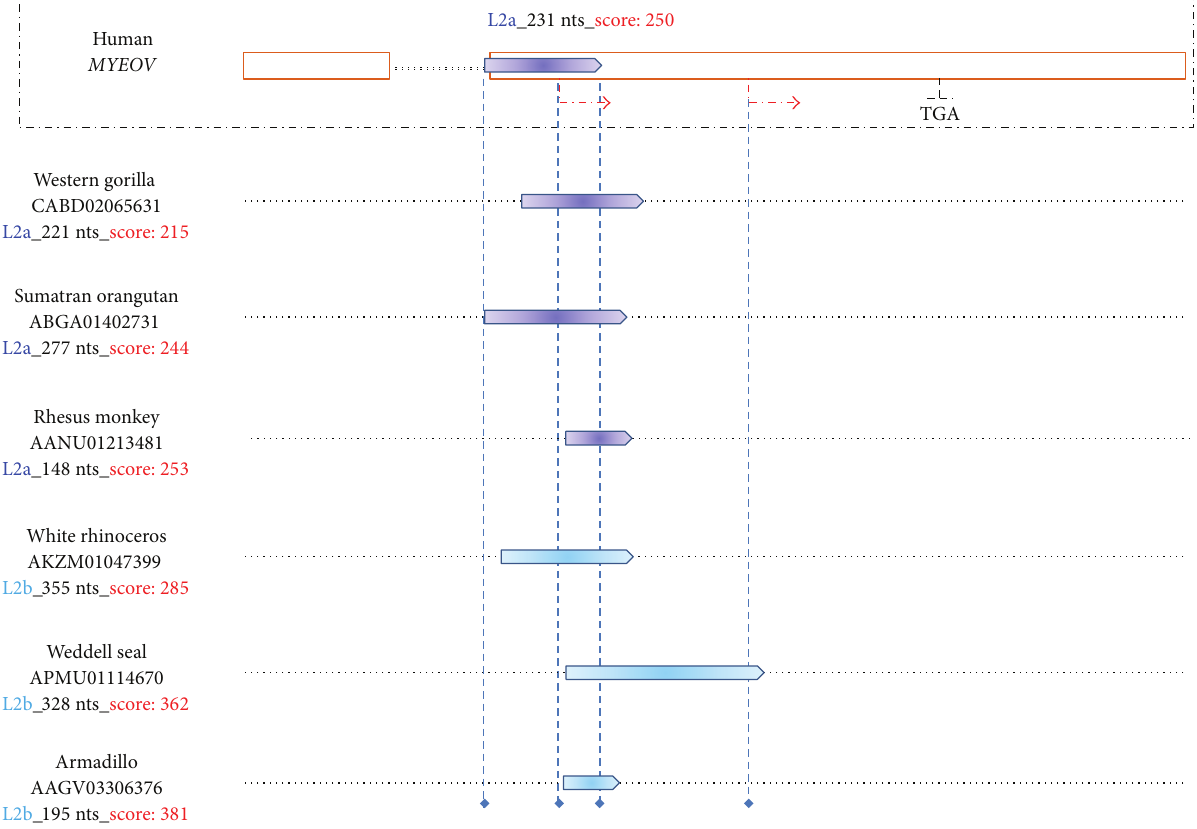
Figure 3: Presence of L2 family-repeat-fossils in MYEOV evolutionary antecedents. Upper panel: illustrated on top is MYEOV locus, as described in Figure 1. Shown is the location of the sense orientation L2 family-repeat followed by RepeatMasker’s annotation in the context of the subfamily name appearing in consensus annotation evidence (dark blue font), the size (black font), and the Smith-Waterman score (red font) of the match. Lower panel: depicted is the presence of L2 family-repeat-relics (pentagons) in MYEOV syntenic region in six mammals, ranging from armadillo to western gorilla. Blue, discontinuous, vertical lines have been used to better visualize the overlap with the human repeat as well as, wherever occurring, the overlap with nonmasked human sequences. Shown in the left flank is the NCBI accession of WGS sequence contigs including the syntenic DNA sequence in each species, followed by the RepeatMasker’s annotation of the degenerated repeat elementincludedinthesyntenicregion.Lengthofwhiterhinocerosandarmadillorepeatsinthefigureisnotinaccordancewiththenucleotide content due to the presence of inserts in the syntenic